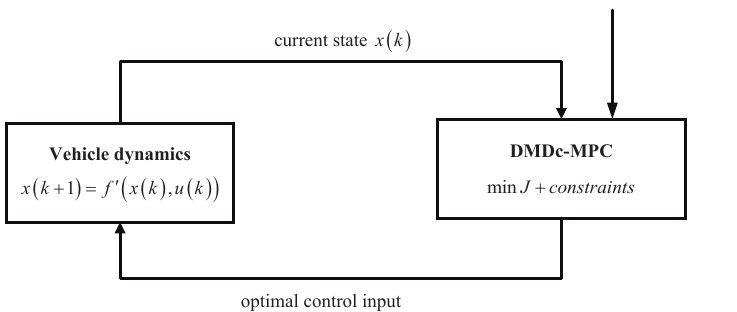
Figure 6. Control diagram of DMDc-MPC based on a Koopman operator.